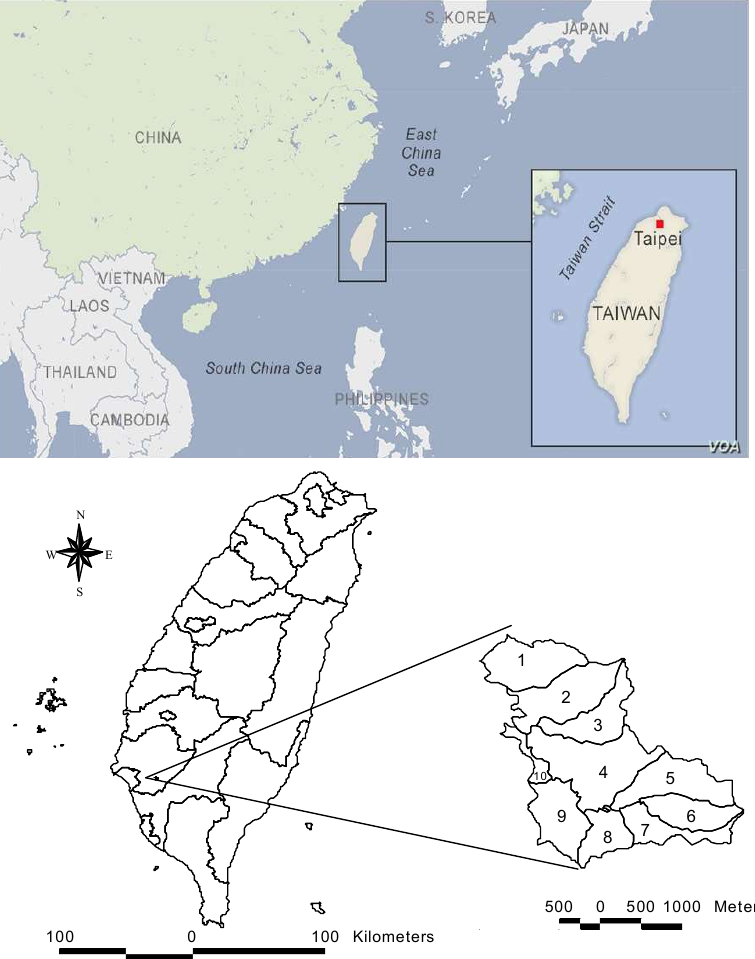
Figure 1. The position map of the Sinhua Forest Park in Taiwan. Source: Chang and Feng (2008) [29].